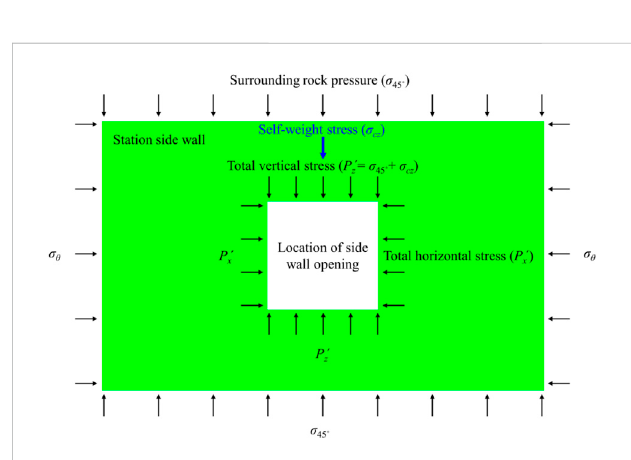
FIGURE 18 Stress distribution in the second “ opening construction ” .